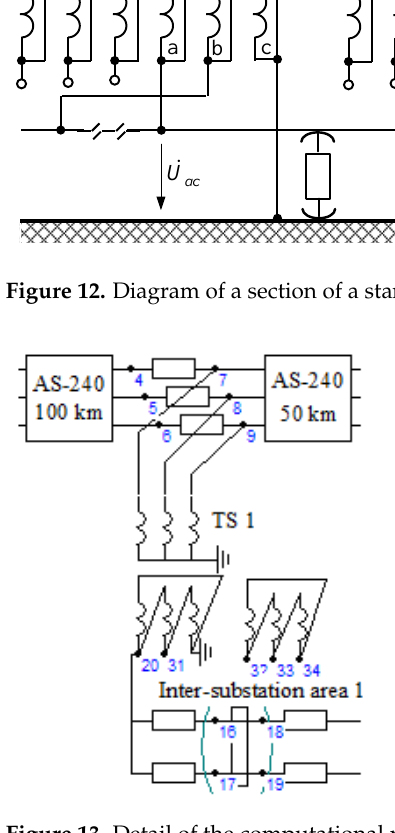
Figure 14. Train schedule.